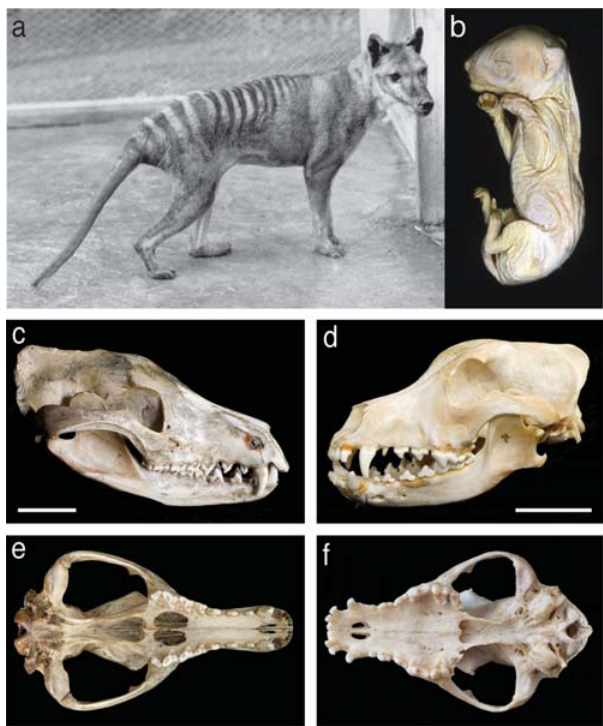
Figure 1. The thylacine, Thylacinuscynocephalus. (a) Young male thylacine in Hobart Zoo in 1928, photograph (Q4437). (b) One of the preserved pouch young specimens (head length 34 mm) from which DNA was extracted, from the Museum Victoria collection. (c-f) The skull of the thylacine (c,e) compared with that of the domestic dog Canis canis (d,f). The morphology of the head shows remarkable convergent evolution. However, there are some differences: in marsupials, the lacrymal extends outside the orbit and the angle of the dentary is medially inflected (c). The thylacine palatine has the vacuities characteristic of marsupial skulls (e). The teeth also show striking convergent evolution but the muzzle of the thylacine is quite narrow compared to that of the dog (e,f). Scale